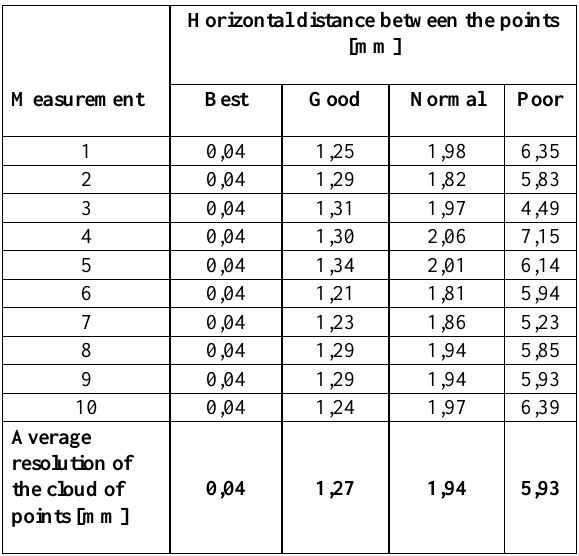
Table 4. Designating the horizontal resolution